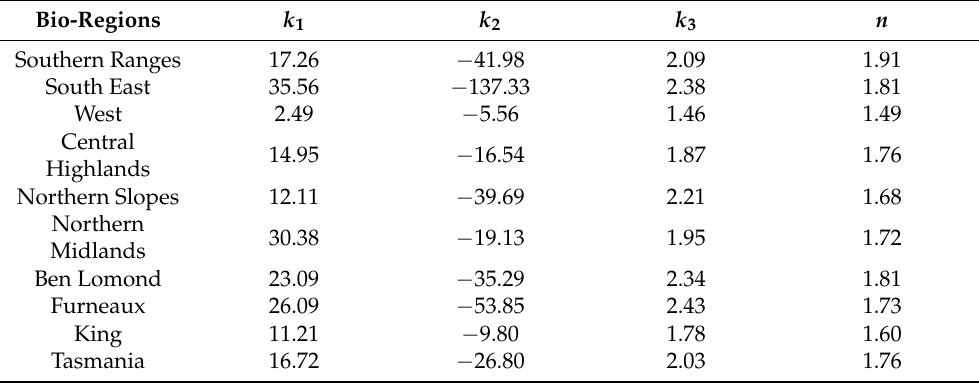
Figure 6. Simulation Data vs. model predicted data for entire Tasmania (The area burnt by the fire is in hectares ( ha ). The red line represents the ideal line where the scatter plots should align for the most accurate surrogate prediction data. The calculated value of correlation coefficient is 0.897, which indicates that the surrogate model closely predicted the actual simulation data.) Table 2. Fitting parameters in the surrogate model for nine bio-regions in